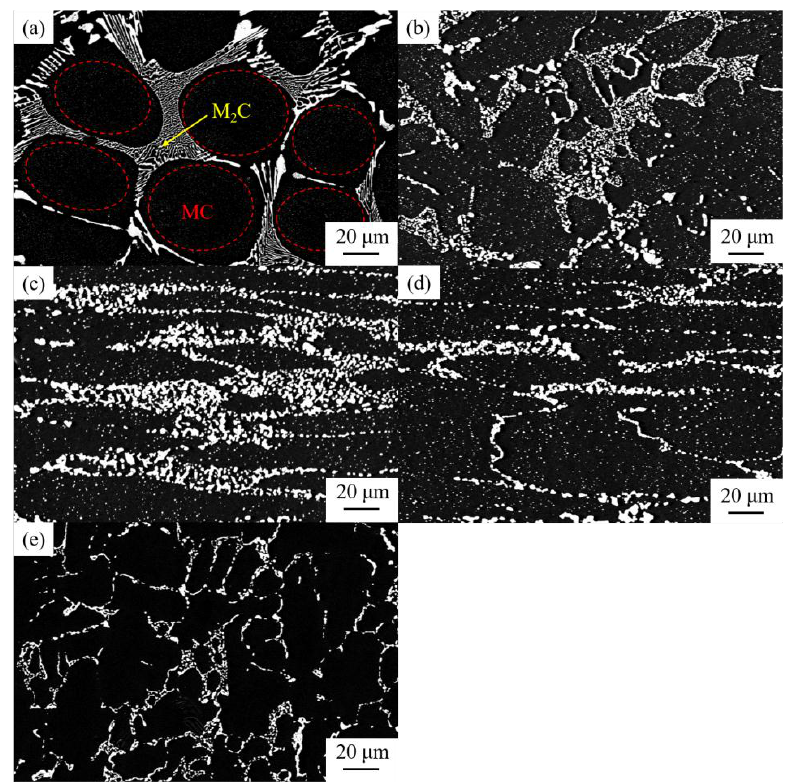
Figure 5. SEM microstructures of the as-cast AISI M42 HSS specimen ( a ); the oil cooling specimens at 1373 K ( b ); 1423 K ( c ); 1453 K ( d ); and 1473 K ( e ).